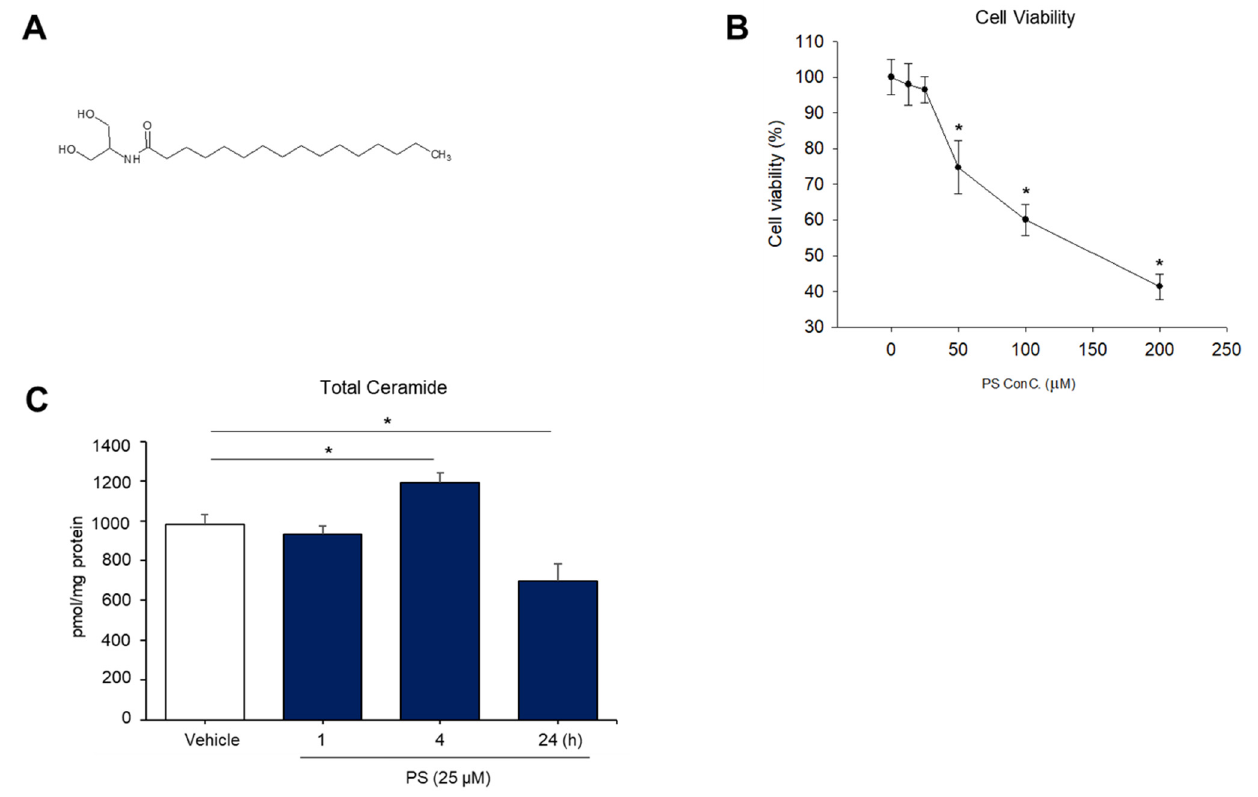
Figure 1. N-palmitoyl serinol (PS)-mediated increase in overall ceramide content in human epidermal keratinocytes (KC). HaCaT KC were incubated with PS (25 μ M or as indicated) for up to 24 h. The molecular structure of PS ( A ) and cell viability measured by the WST-1 assay ( B ). Total ceramide content was assessed by the LC-MS/MS system ( C ). Statistical significance was calculated using the unpaired Student’s t -test, and significance was defined as * p < 0.01 vs. vehicle control (or untreated control).